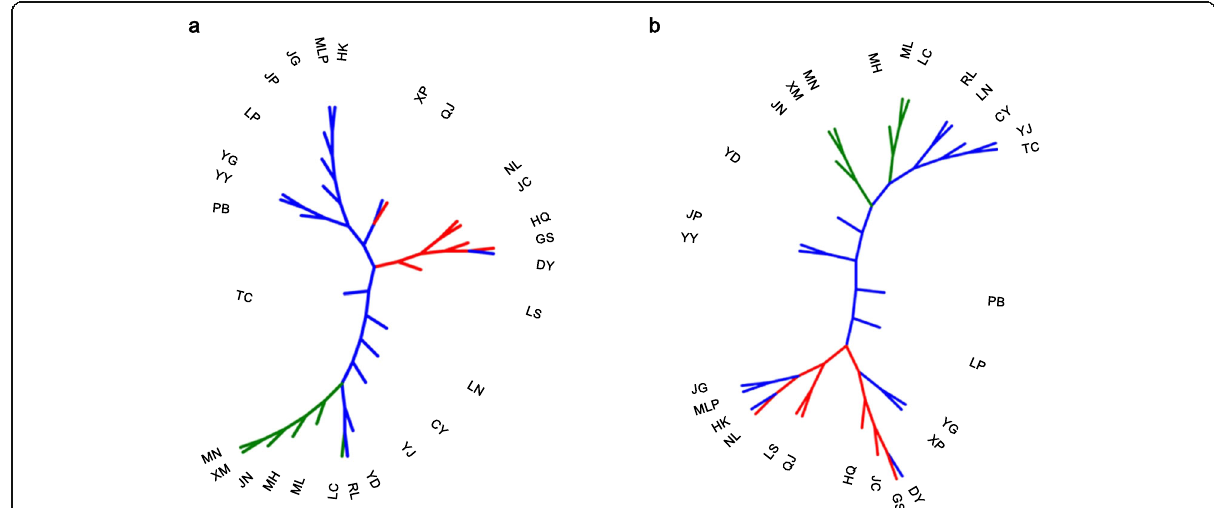
Fig. 2 Unrooted neighbor-joining trees of the rice landraces from 28 locations based on Nei ’ s genetic distances in japonica ( a ) and indica ( b ) groups. Colours for rice landraces collected from different locations: red, from northern locations (N); green, from southern locations (S); blue, from middle locations